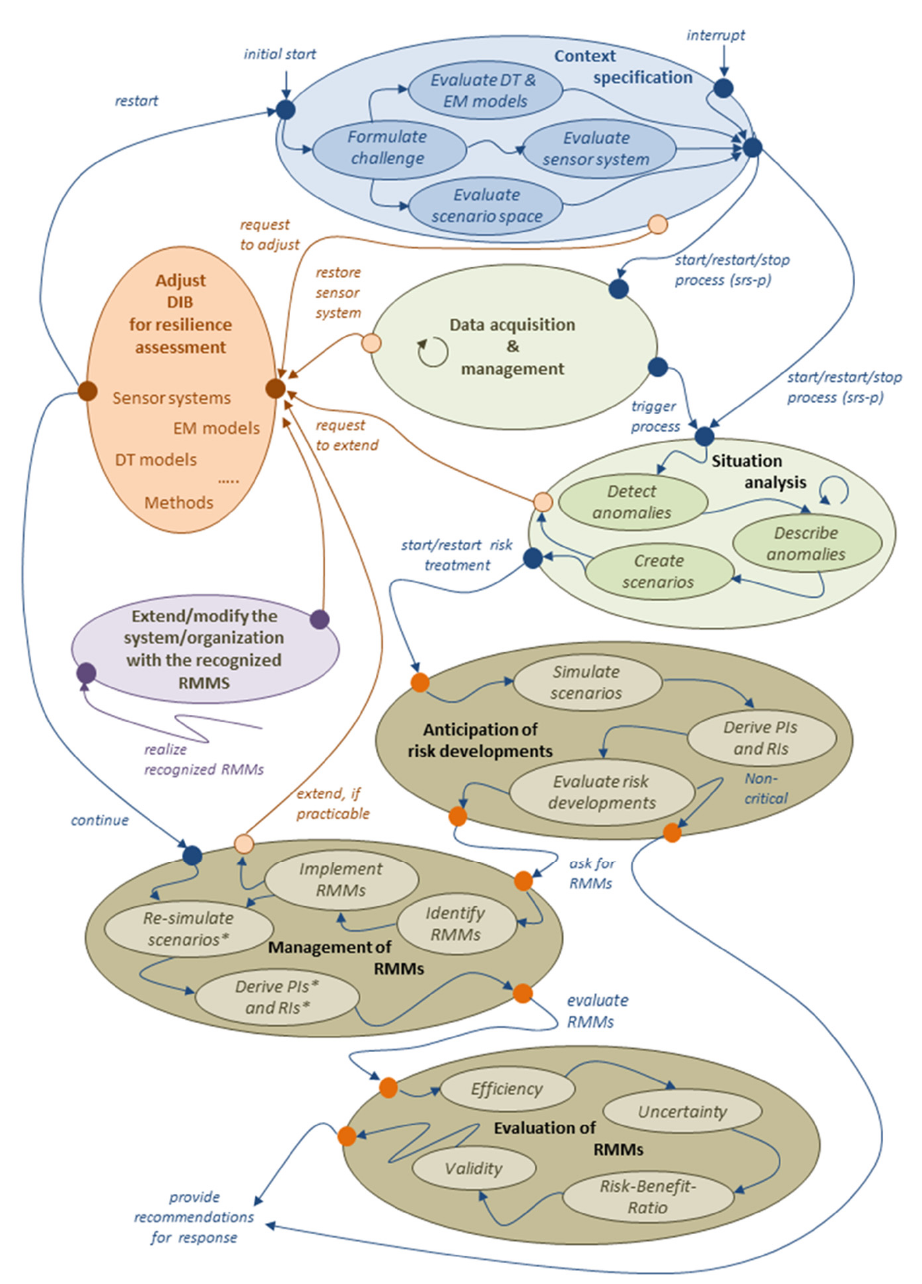
Figure 2. Cycle and main tasks of the resilience management process.